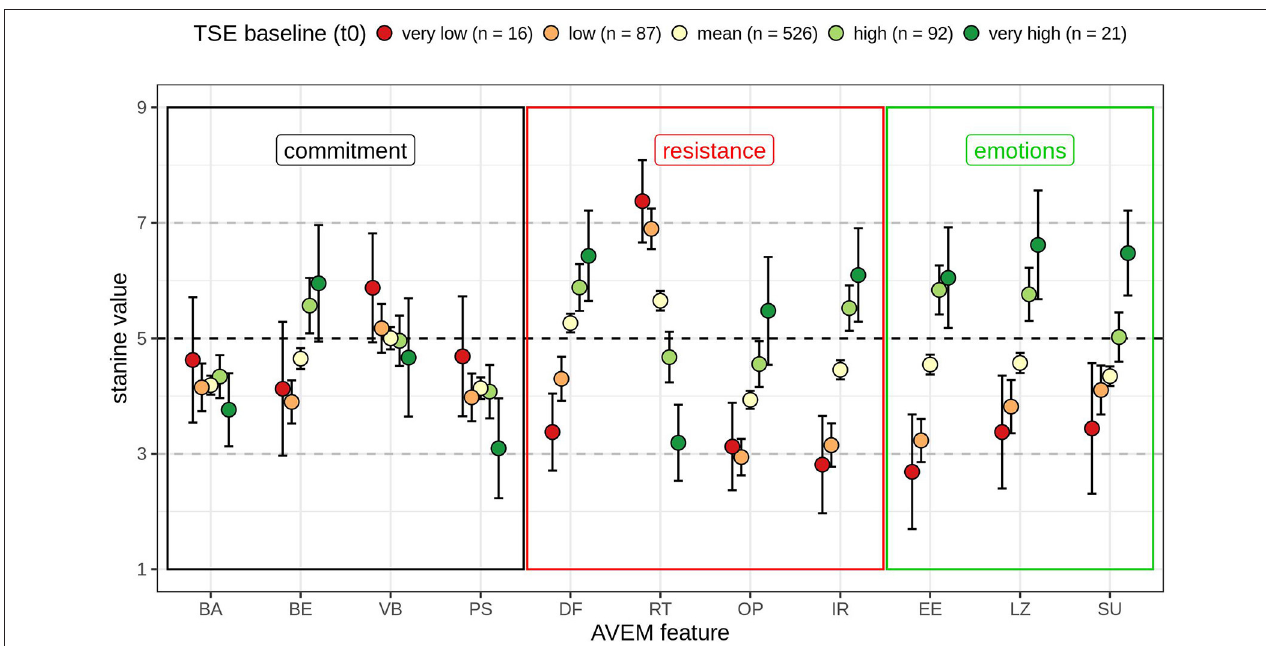
FIGURE 2 | Teacher self-efficacy at t 0 ( N = 742; very low: TSE t 0 ≤ M – 2 SD; low: M – 2 SD < TSE t 0 ≤ M – 1 SD; mean: M – 1 SD < TSE t 0 < M + 1 SD; high: M < TSE t 0 ≤ M + 1 SD; very high: M + 2 SD ≤ TSE t 0 ) with mean stanine values ( M = 5, SD = 2) and 95% confidence interval by AVEM subscale or feature (BA, subjective importance of work; BE, professional ambition; VB, willingness to work to exhaustion; PS, striving for perfection; DF, distancing ability; RT, resignation tendency toward failure; OP, proactive problem-solving; IR, inner calm and balance; EE, experience of success at work; LZ, general life satisfaction; SU, experience of social support). The AVEM subscales or features are grouped within their corresponding resources: commitment, work commitment (black); resistance, psychological resistance factors (red), and emotions